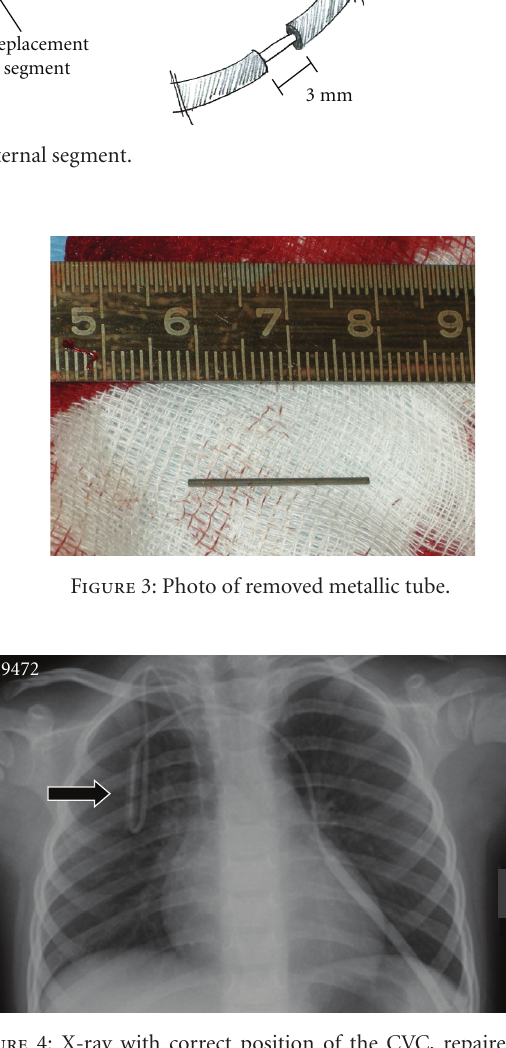
Figure 4: X-ray with correct position of the CVC, repaired area indicated by